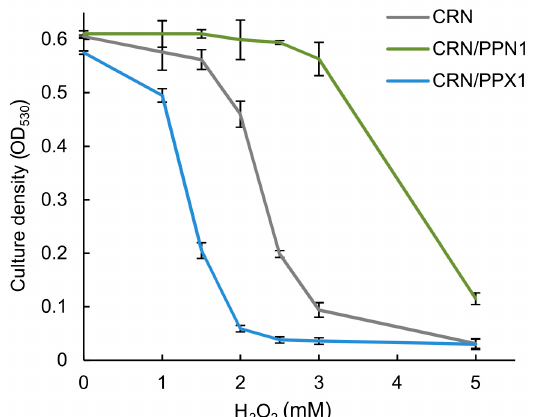
Figure 3. The effect of H 2 O 2 on the growth of the CRN, CRN/PPN1, and CRN/PPX1 strains of S. cerevisiae in YPD medium. CRN is shown in gray, CRN/PPN1 in green, and CRN/PPX1 in blue. Three replicates were performed for each experiment; mean ± s.d. is given.